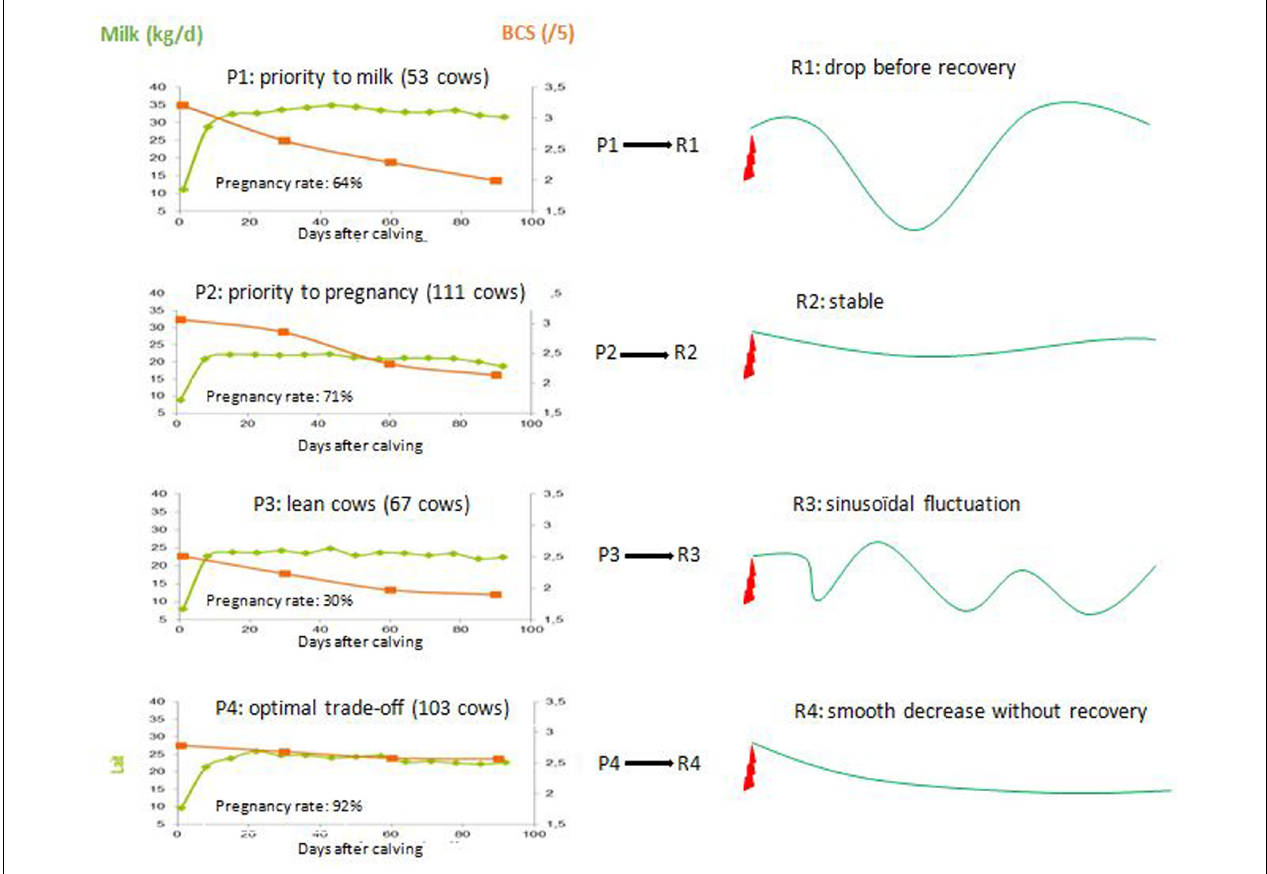
FIGURE 2 | Relationships between four individual trade-off profiles (P1-4 accounting for daily milk yield in green, body condition score in orange, and pregnancy rate during current lactation) of dairy cows measured in early lactation when competition between the functions is the highest, with their milk yield response (R1-4) to a perturbation (adapted from Ollion et al.,